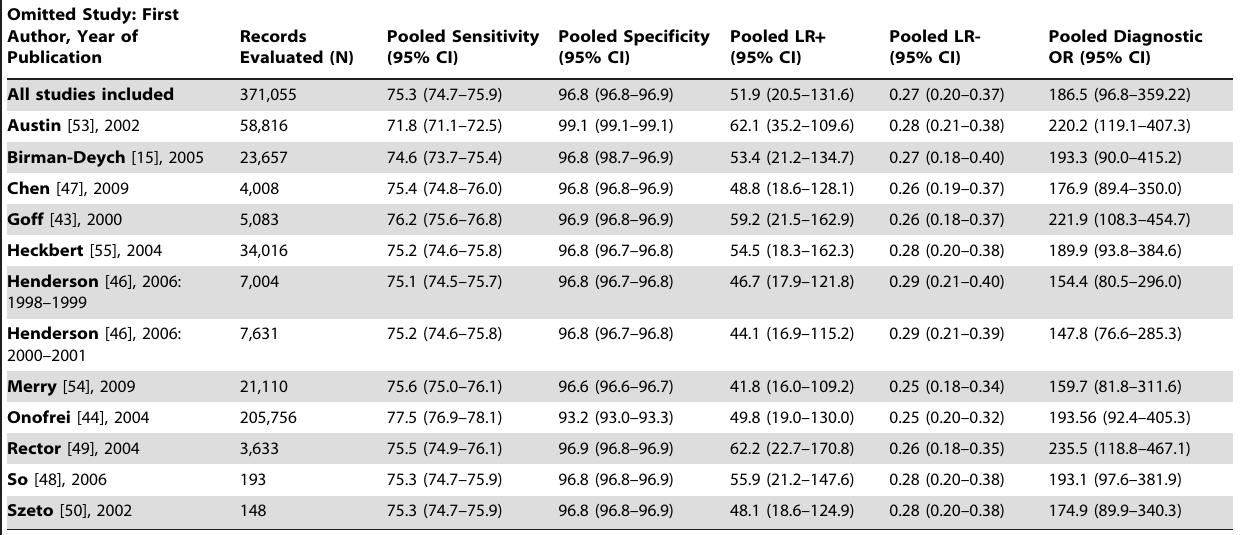
Table 3. Results of Sensitivity Analysis Using a Jackknife